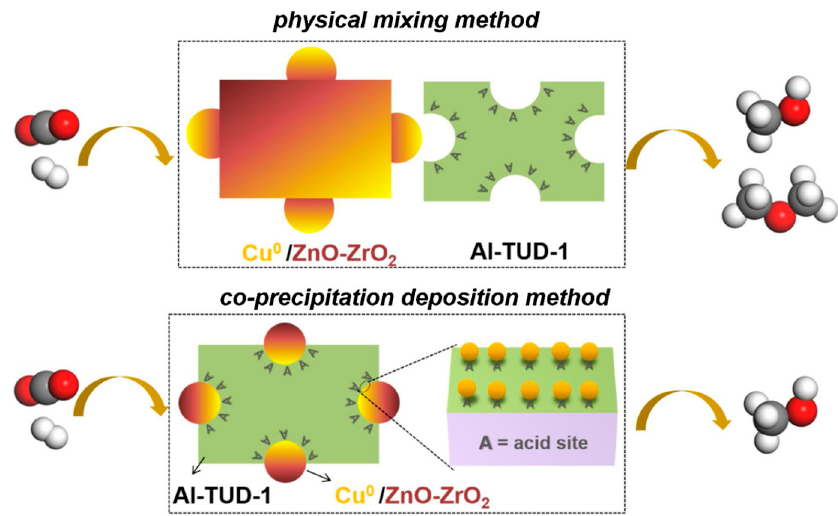
Figure 14. Schematic visualization of hybrid catalysts based on CuO-ZnO-ZrO 2 + mesoporous alumino-silicate prepared by the physical mixing method and co-precipitation deposition (reproduced from [142] with permission from Elsevier License No 5015270559789).